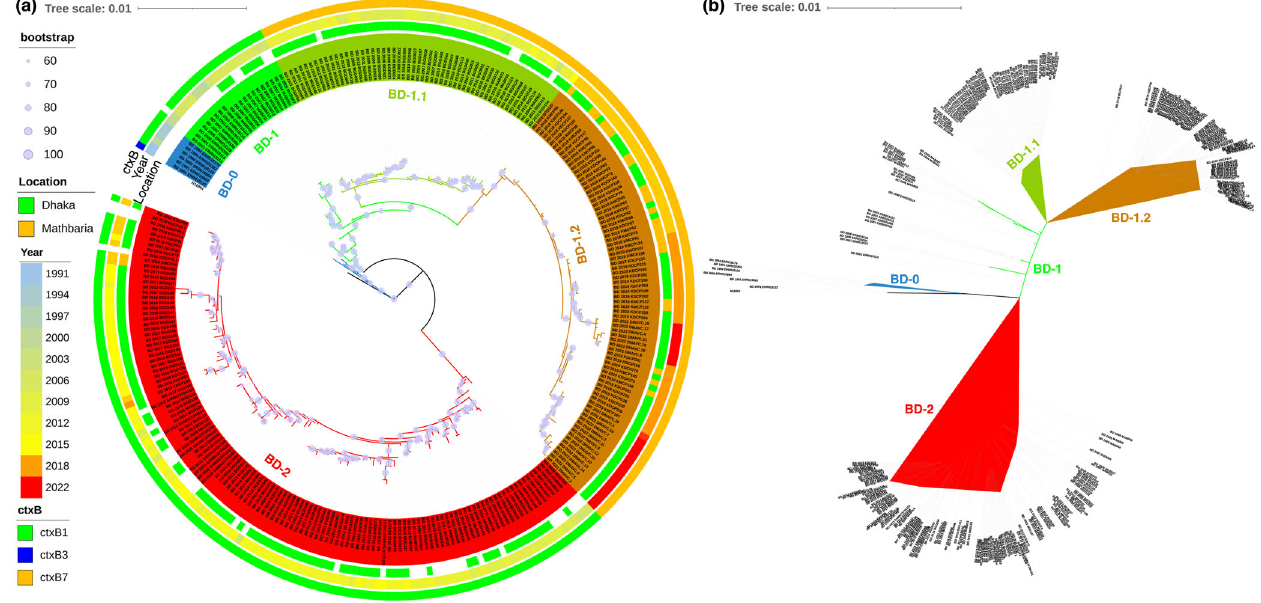
Fig. 1 | Phylogenetic clustering of Bangladesh V. cholerae strains. a Maximum likelihoodphylogenetictreerootedfromout-groupreferencestrain Vibriocholerae N16961 based on whole genome SNPs and the strains belonging to lineages BD-0, BD-1,BD-1.1,BD-1.2,andBD-2.Metadataofisolatesaredisplayedinringsaccording to color scheme on the left. Lineages BD-0, BD-1, BD-1.1, BD-1.2, and BD-2 are